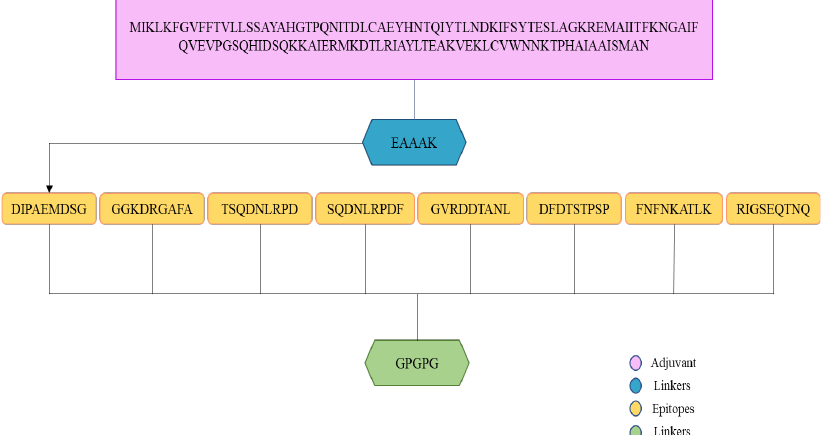
Figure 6. An illustration of the vaccine construct. A light orange color indicates that the epitopes are linked by the GPGPG linker (green color). Adjuvants (cholera toxin B-subunit) and receptors (EAAAK) are represented by pink and blue colors,